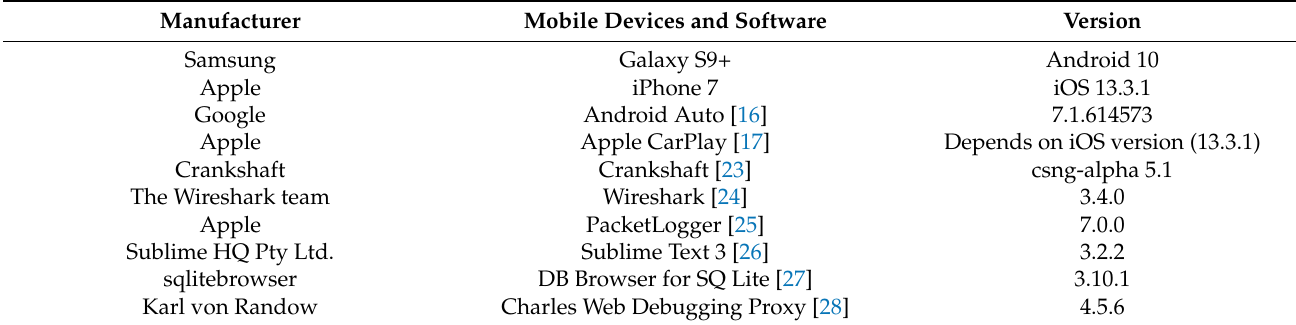
Table 2. Specification of mobile devices and software used in case studies.